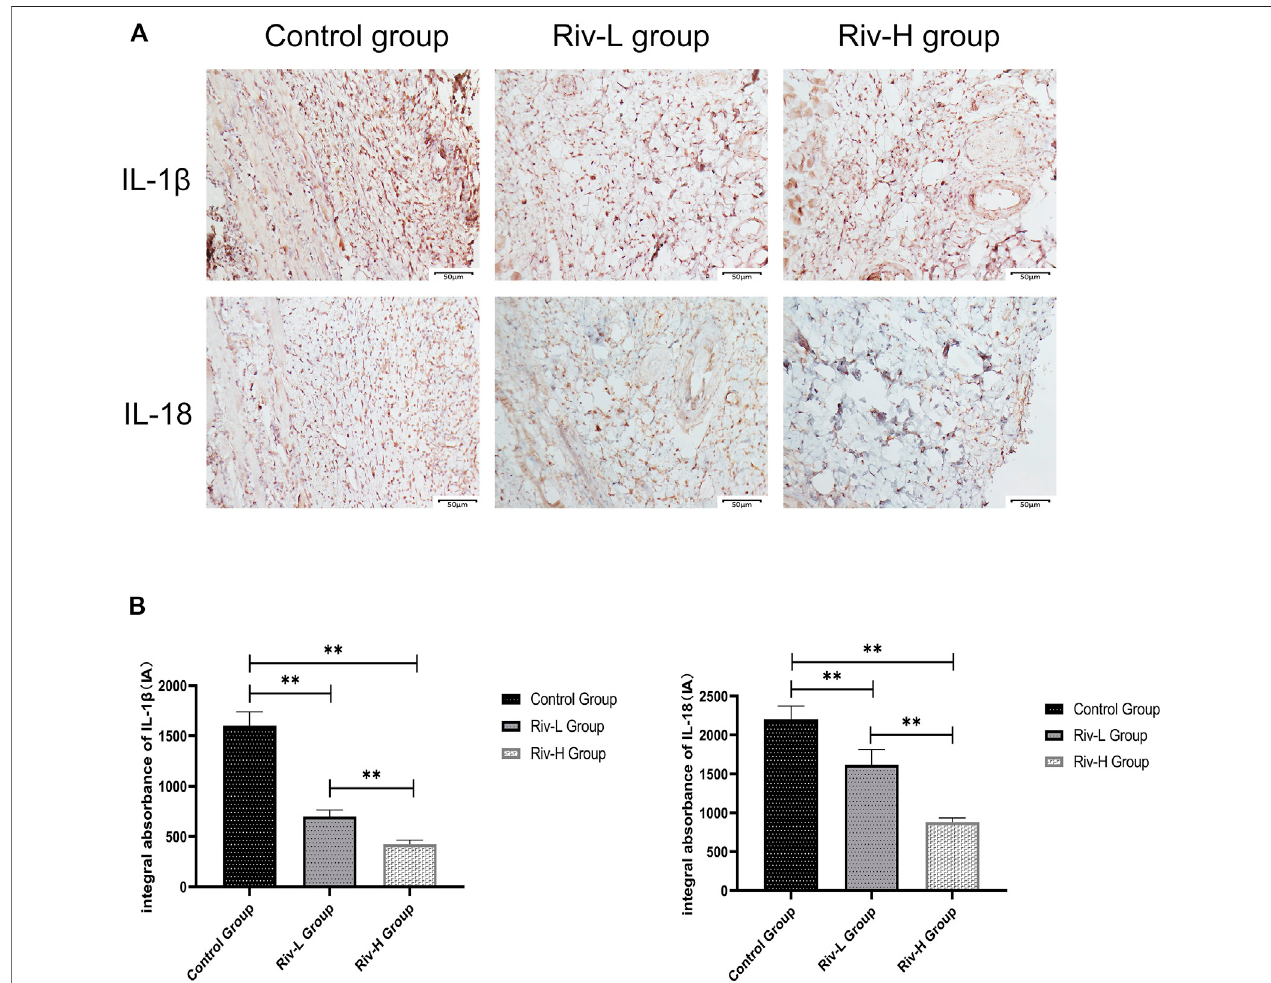
FIGURE5|(A) Thetissues inarea IIofthe fl aps inthethree groupsweresubjectedtoimmunohistochemicalanalysistoexamineIL-1 β and IL-18expression ( × 200 magni fi cation) (B) The levels of IL-1 β and IL-18 expression were quanti fi ed by measuring IA. ** p < 0.01.